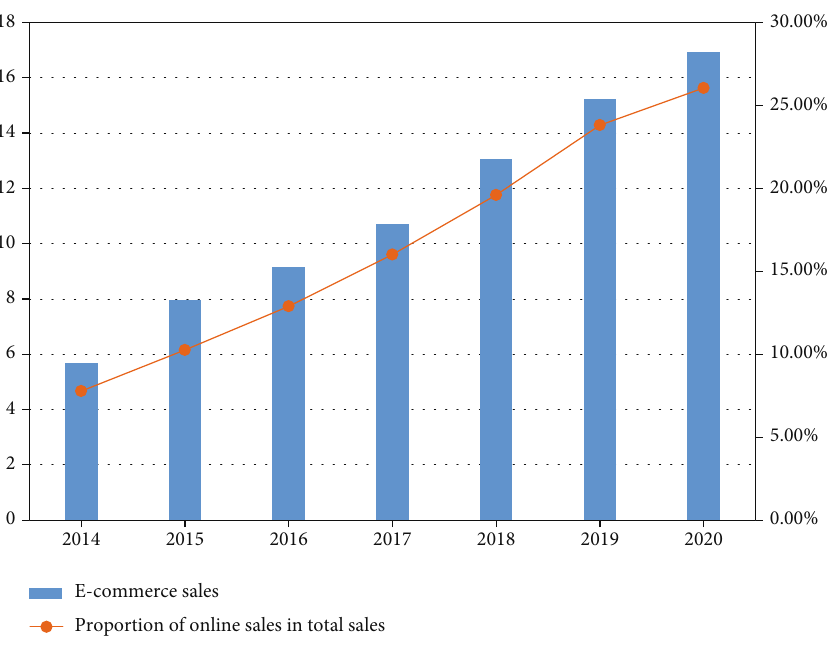
Figure 5: Statistics of the proportion of e-commerce online sales in total sales from 2014 to 2020.